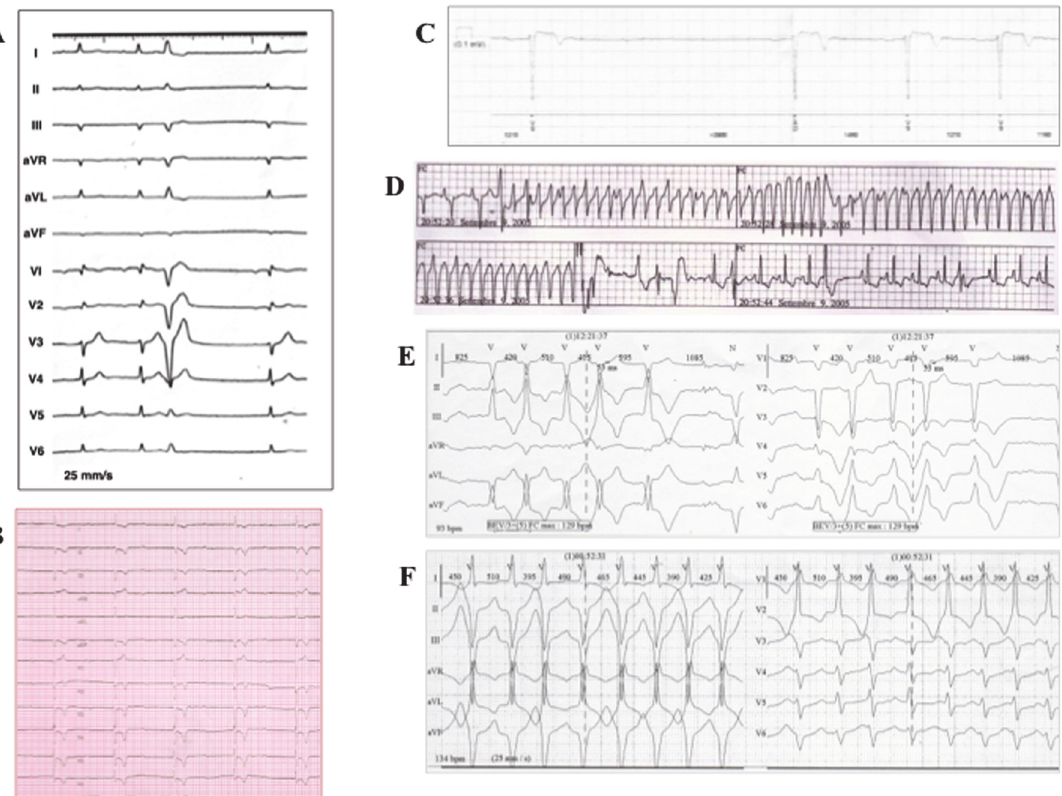
Fig 2. Clinical characteristics of index patient and LMNA mutation-positive family members. Index patient ’ s electrocardiogram (ECG) showing, at clinical presentation, (A) sinus rhythm, first-degree AV block, and PVC of LBBB morphology and, 13 years later, (B) complete AV block. (C) Asystole documented on implantable loop recorder memory (subject III-8). (D) Sustained VT detected on telemetry monitoring, effectively terminated by internal ICD shock (subject III-1). (E) Episodes of non-sustained VT with LBBB morphology and inferior axis (subject III-5) on 12-lead Holter monitoring. (E) Episodes of non-sustained VT with RBBB morphology and superior axis (subject IV-2) on 12-lead Holter monitoring.